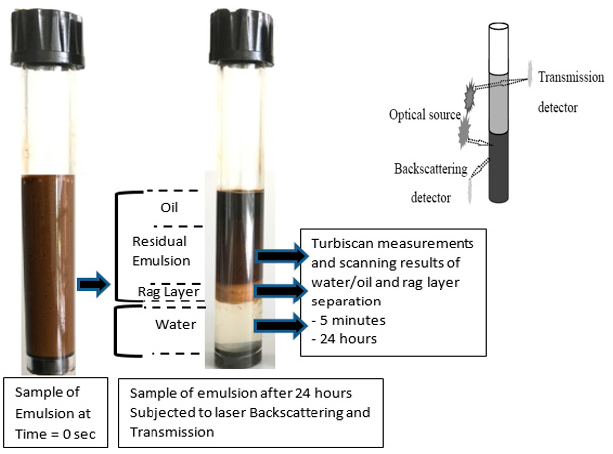
Figure 2. Measuring principle of Turbiscan or experimental measurement of separation from the emulsion sample by sedimentation (back sca tt ering) and coalescence (light transmission).